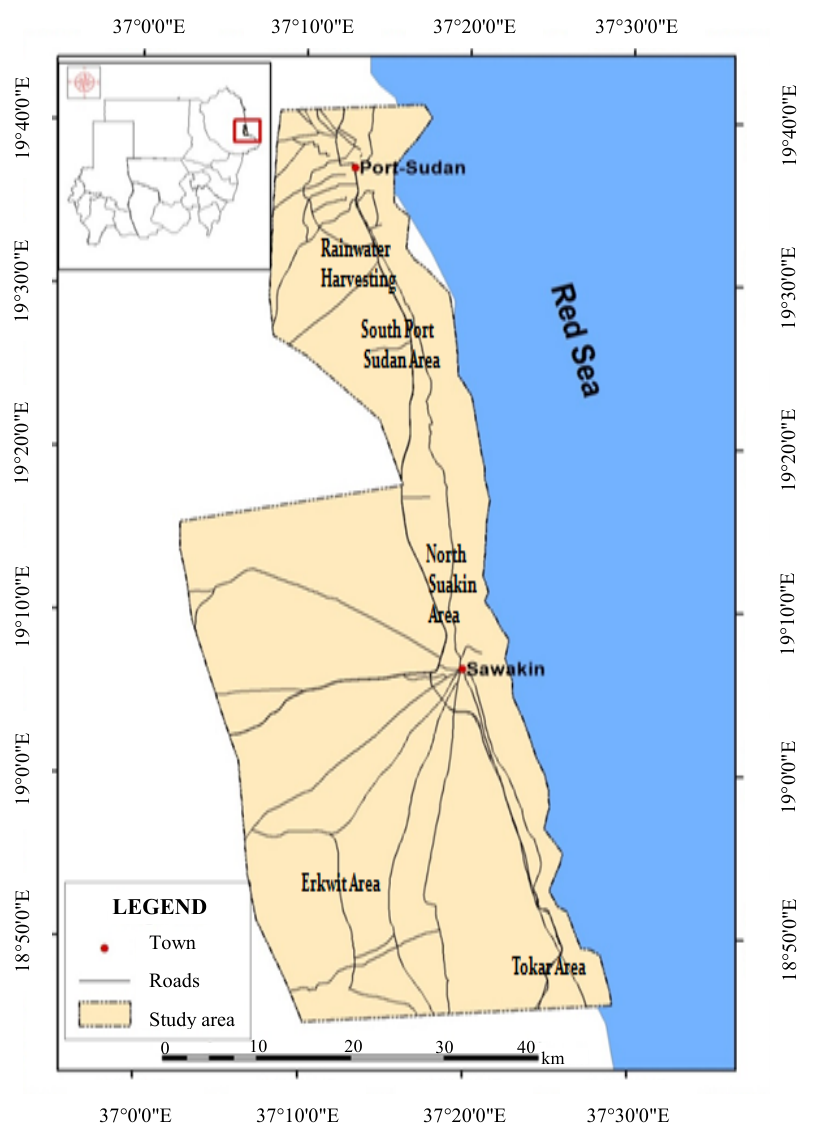
Figure 1. Map showing the study area along the Sudanese Red Sea coastal plain, south of Port Sudan.